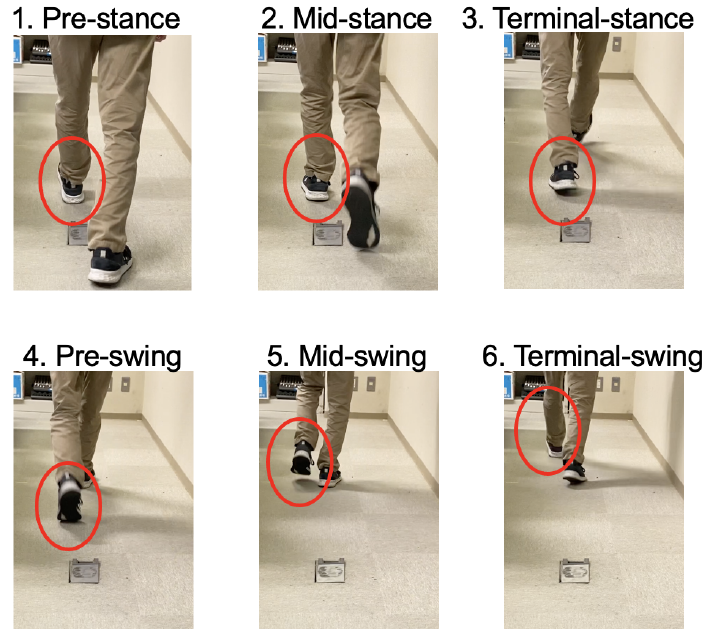
Figure 3. Gait phases (there are six gait